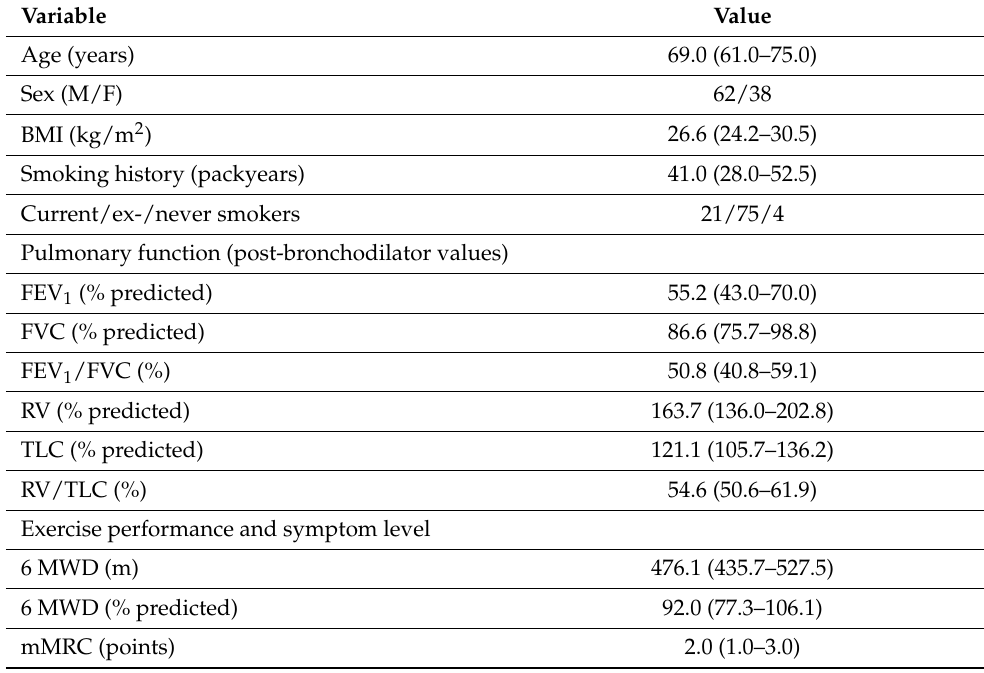
Table 1. Characteristics of the investigated